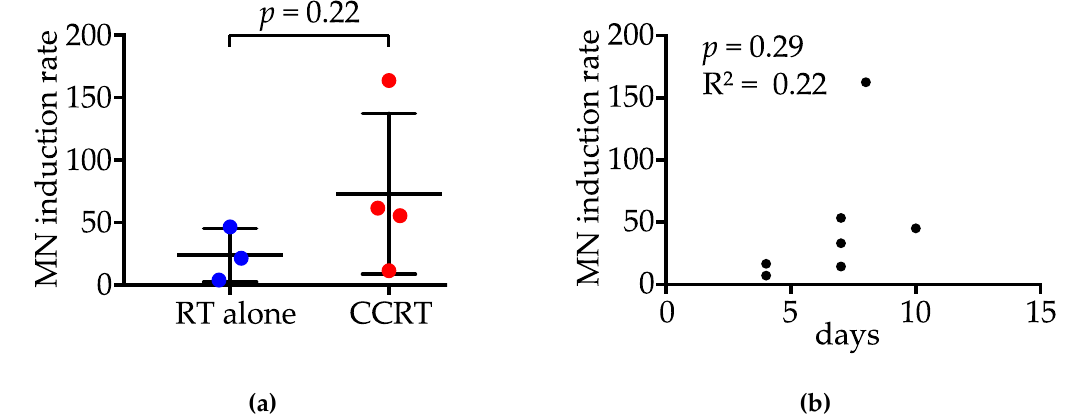
Figure 3. The number of nuclei harboring micronuclei (MN) ( a ) and those undergoing apoptosis (Ap) ( b ) pre-radiotherapy or after 10 Gy RT. p values were assessed by the paired non-parametric Wilcoxon test.